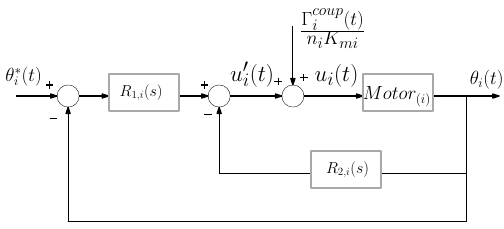
Figure 7. Motor control loop